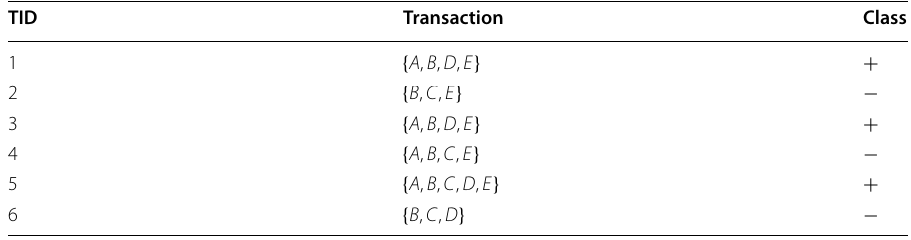
Table 1 An example transactional dataset, binary-labeled TID Transaction Class